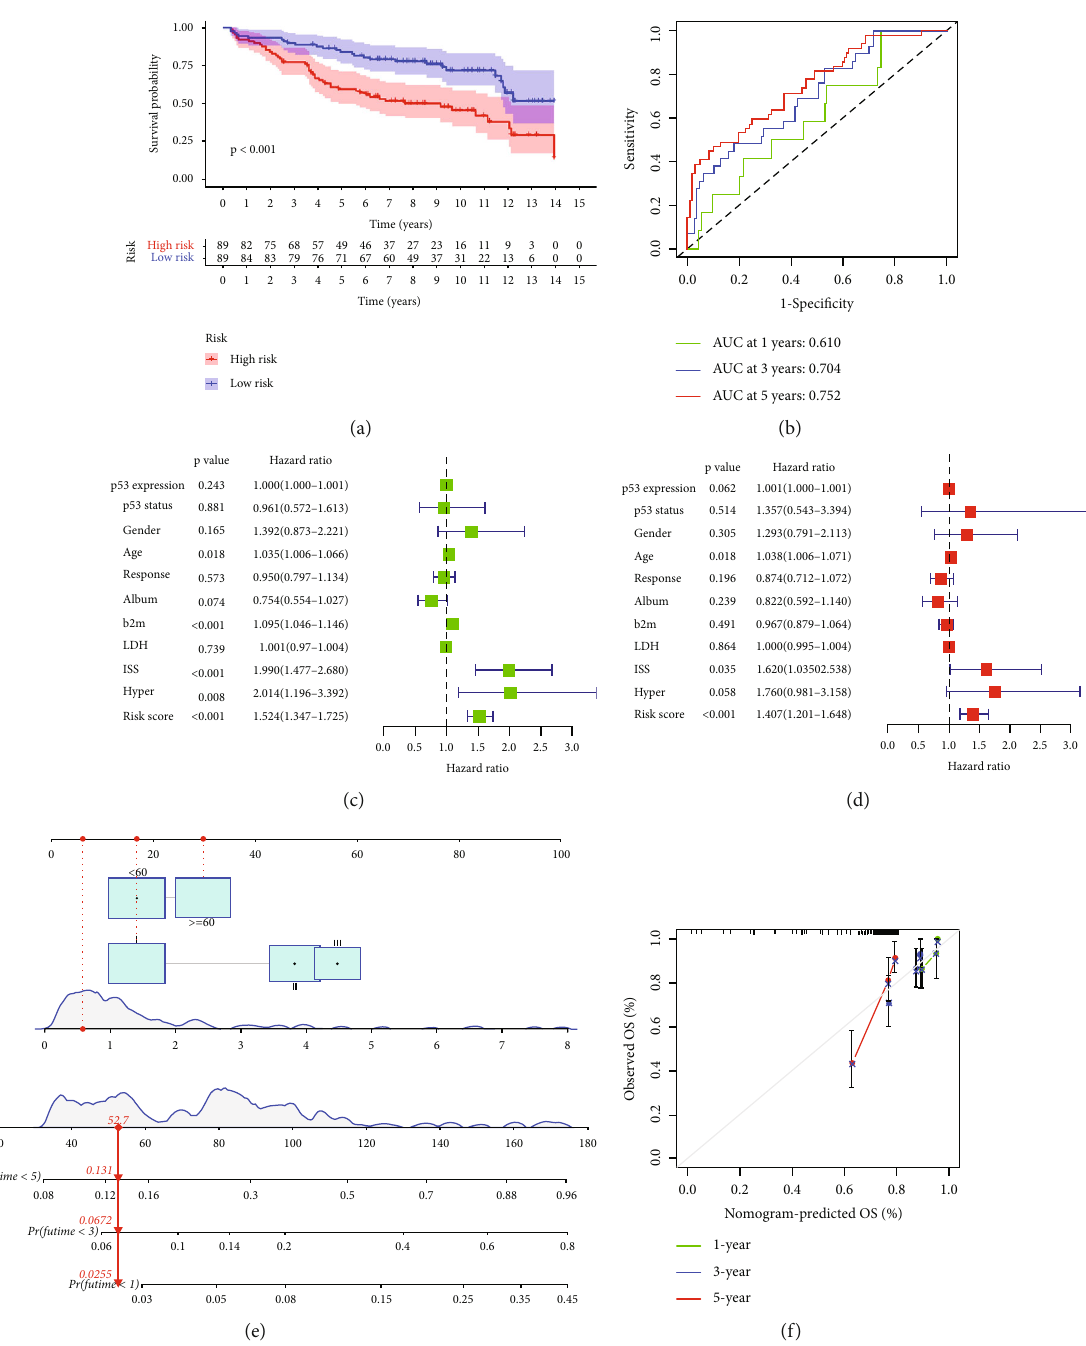
Figure 3: Evaluation of the prognostic features of OS-related ARGs in multiple myeloma patients. (a) Survival status of the low- and high- risk cohorts. (b) ROC curves for anticipating OS over one, three, and fi ve years. (c) Univariate Cox regression analysis of clinical- pathological variables and risk score. (d) Multivariable Cox regression analysis of clinical characteristics and risk score. (e) Nomograms to predict the MM patients ’ OS over one, three, and fi ve years by combining ISS stage, age, and risk score. (f) The accuracy of the predicted survival rates over one, three, and fi ve years was validated using calibration curves of nomograms. The dashed line indicates an ideal nomogram, whereas the green, blue, and red solid lines refer to the actual utility of the